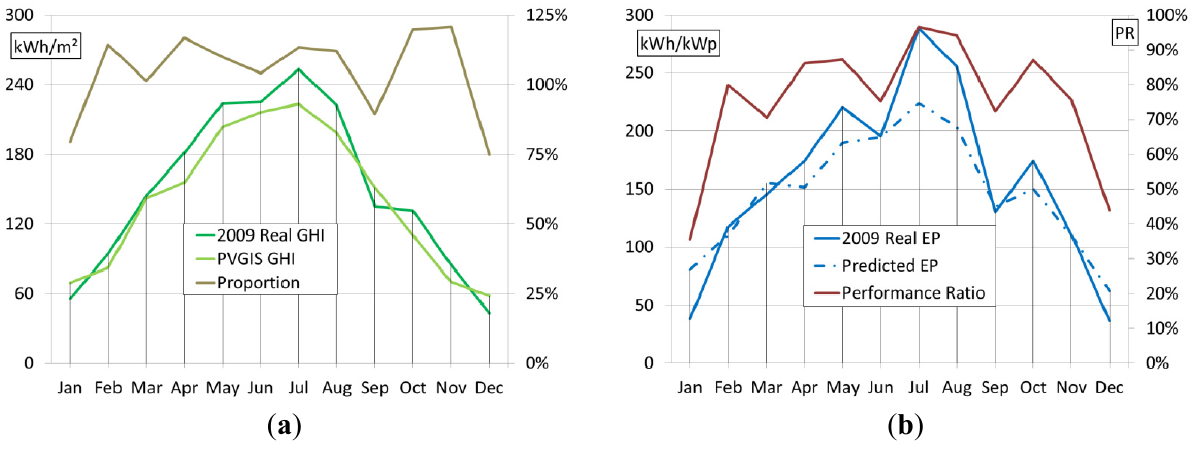
Figure 7. ( a ) PVGIS GHI, real GHI, and their proportion in 2009; ( b ) Real EP, EP prediction based on constant PR, and estimated PR values for Puertollano CPV installation in 2009.